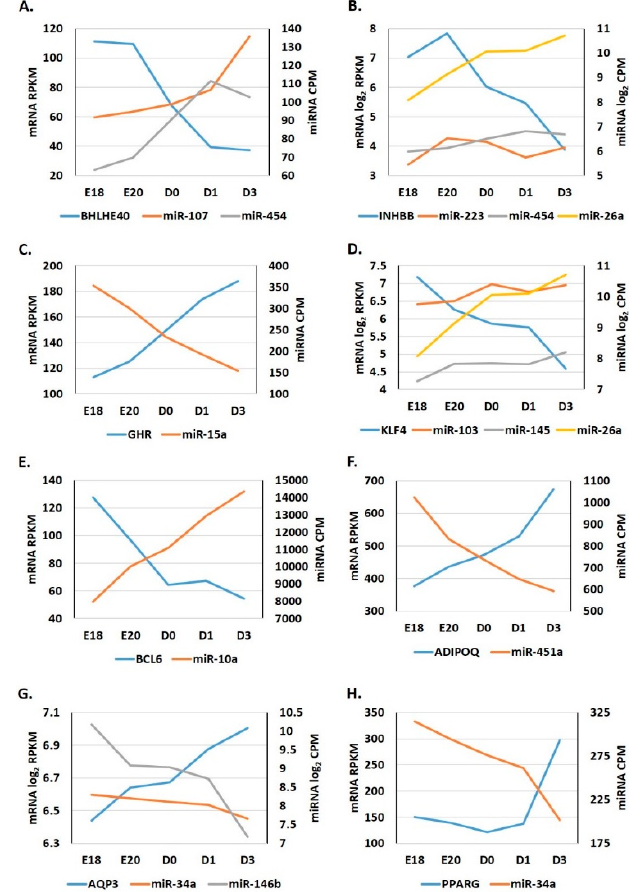
Figure 2. ( A ) Representative selection of miRNA:target gene adipocytic expression signatures in peri-hatch white leghorn chicks. The expression profiles of miRNAs and gene transcripts in the adipose tissue of E18, E20, D0, D1, and D3 chicks were determined using small RNA-seq and RNA-seq analyses. A. Expression of BHLH40 and its targeting miRNAs, miR-107 and miR-454 . ( B ) Expression of INHBB and its targeting miRNAs, miR-223 , miR-454 , and miR-26a . ( C ) Expression of GHR and its targeting miRNA, miR-15a . ( D ) Expression of KLF4 and its targeting miRNAs, miR-103 , miR-145 , and miR-26a . ( E ) Expression of BCL6 and its targeting miRNA, miR-10a . ( F ) Expression of ADIPOQ and its targeting miRNA, miR-451a . ( G ) Expression of AQP3 and its targeting miRNAs, miR-34a and miR-146b . ( H ) Expression of PPARG and its targeting miRNA, miR-34a . Data are presented as normalized expression values: RPKM for mRNA and CPM for miRNA.